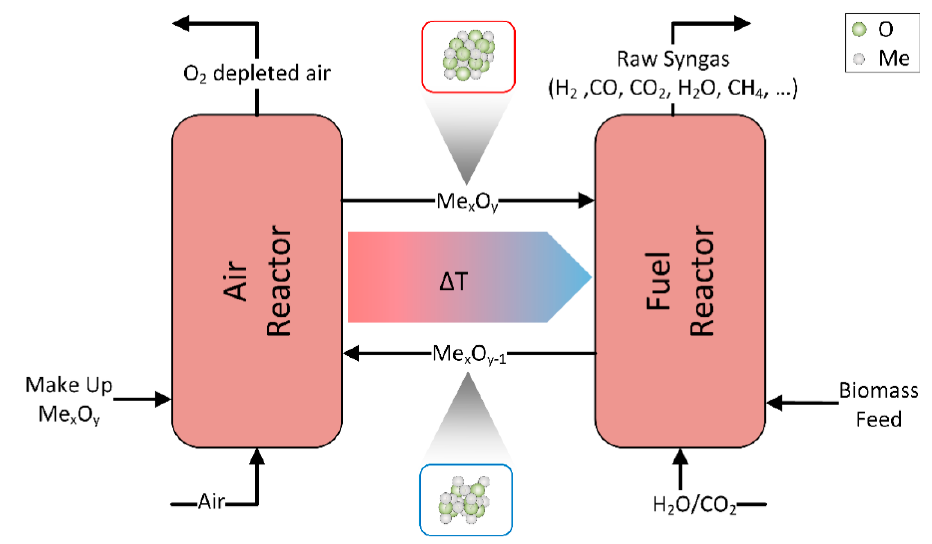
Figure 4. Schematic description of chemical looping process [45].